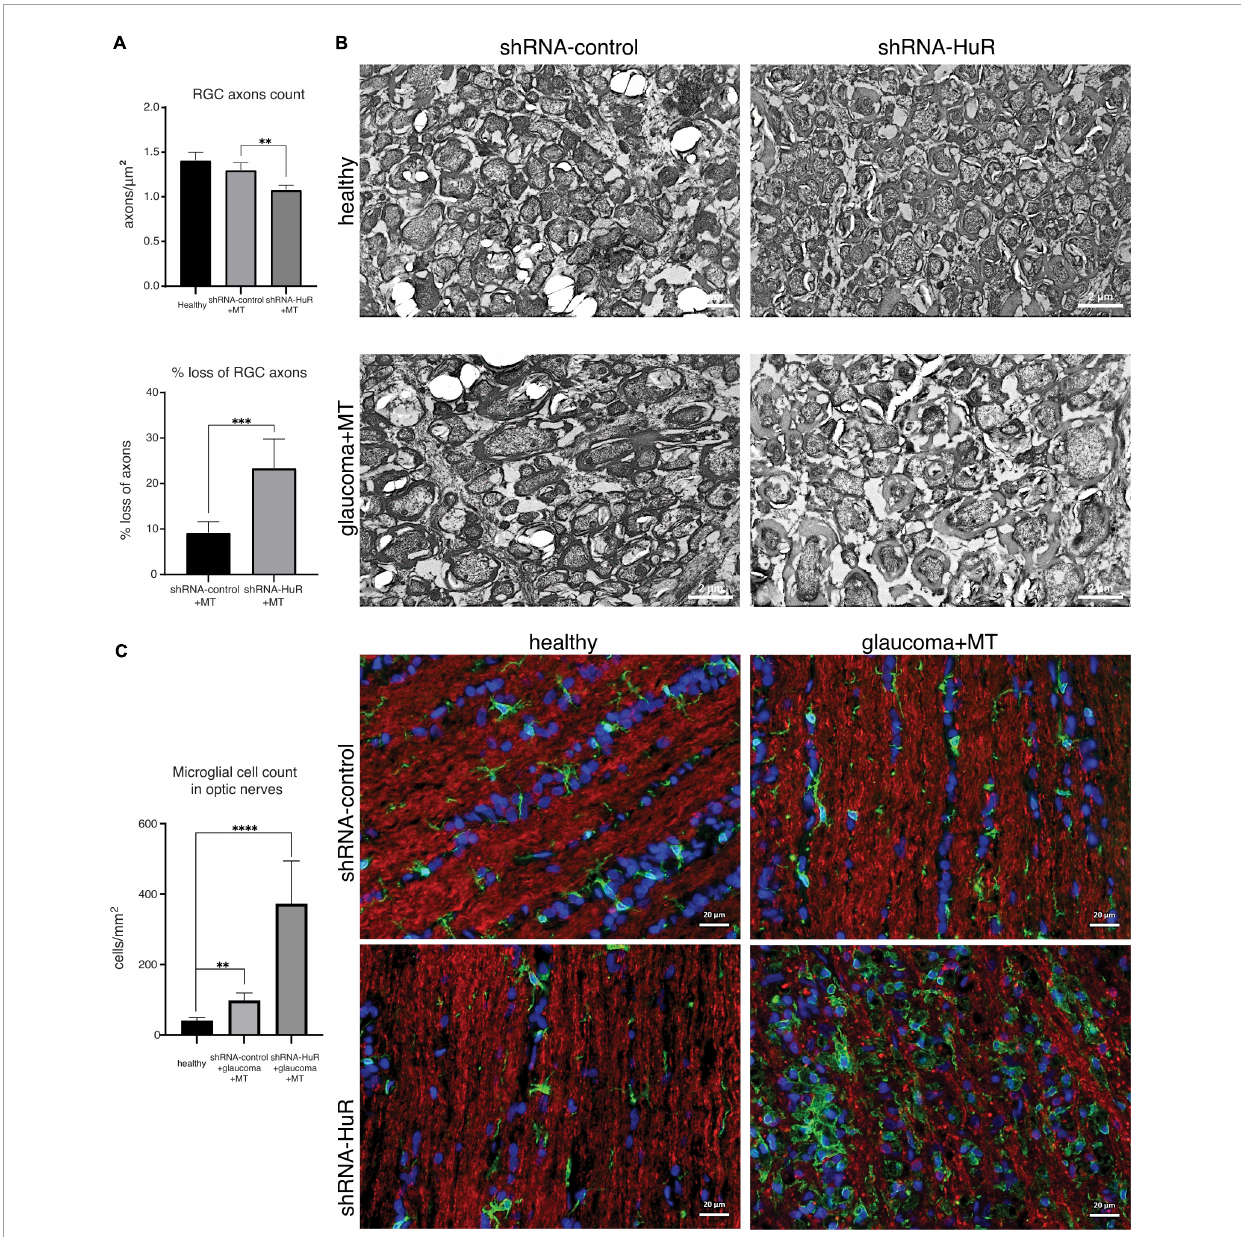
FIGURE8 The exogenous neuroprotection study. Optic nerve histology analysis. (A) Optic nerve axon count and estimated loss between groups based on electron microscopy of optic nerve cross sections, n = 5 animals per group, 10 ultramicrographs per optic nerve, ∗∗ p < 0.01, ∗∗∗ p < 0.003. (B) Representative electron micrographs of optic nerve cross sections, scale bar = 2 µ m. (C) Immunofluorescence staining of optic nerve longitudinal sections for Iba-1 (green) merged with Tuij-1 (red) and DAPI (blue) and cell quantification. The pattern of Iba-1-positive macrophage infiltration was similar to that observed in the retinal whole-mounts. ∗∗ p < 0.01, ∗∗∗∗ p < 0.001. Scale bar = 20 µ